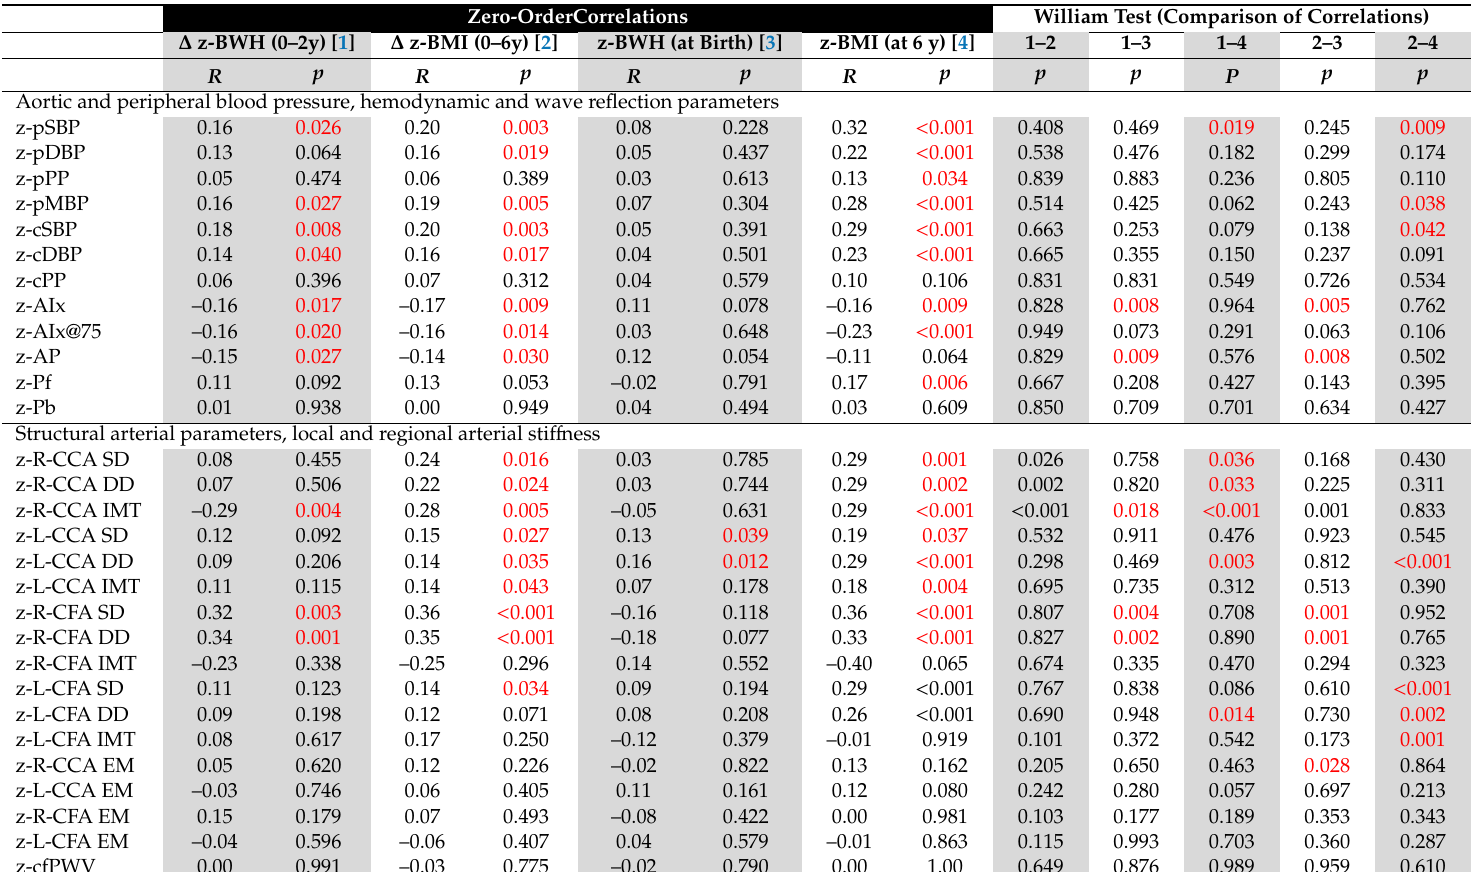
Table 2. Comparative analysis CV variables’ association with anthropometric characteristics at birth, at 6 y and with anthropometric changes within that period (0–2 and 0–6 y) (children cohort, n = 632).